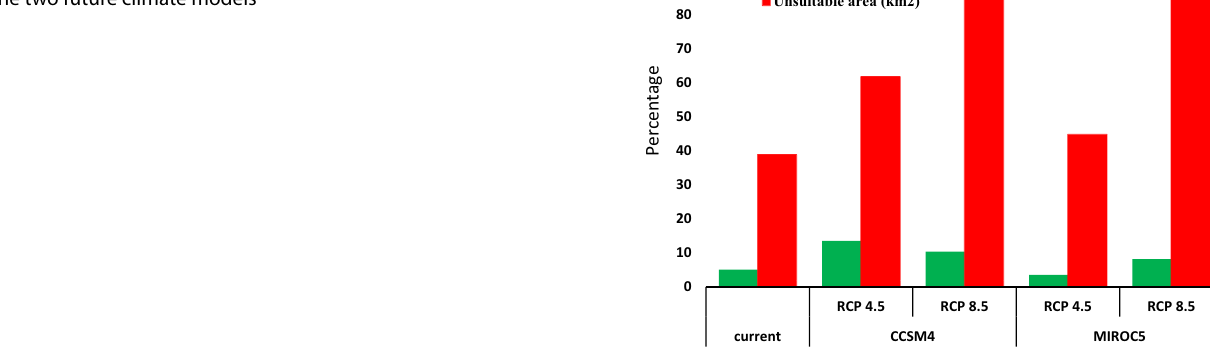
Fig. 5 The suitable areas for A. leocarpa in the present